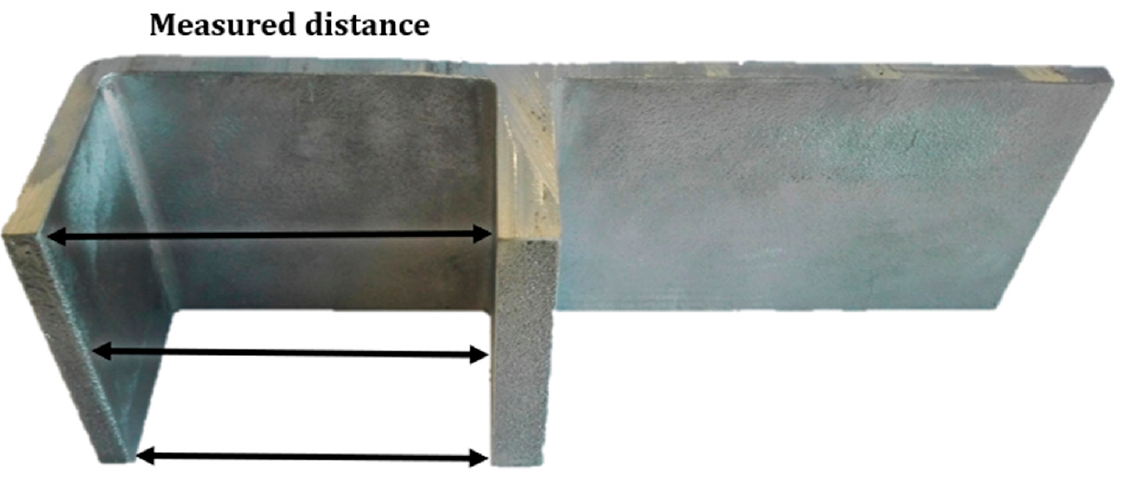
Figure 11. A Cast specimen with the initial geometry. On the left the measuring points for the component distortion are shown.